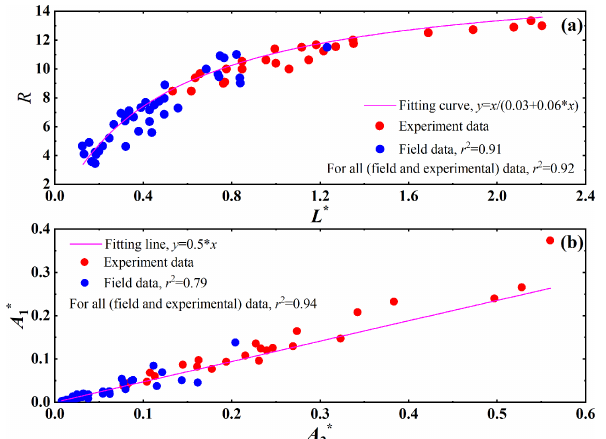
Figure 10. Geometry characteristics of boulder bars after the dam failed in the field. The experimental data are also plotted in the fig- ure to compare to the field data. (a) The relationship between boul- der bar length to width ratio ( R ) and dimensionless length ( L ∗ ); (b) the relationship between a boulder bar’s dimensionless area ( A ∗ ) and the cross-sectional dimensionless area of the river channel 1 along the boulder bar ( A ∗ 2